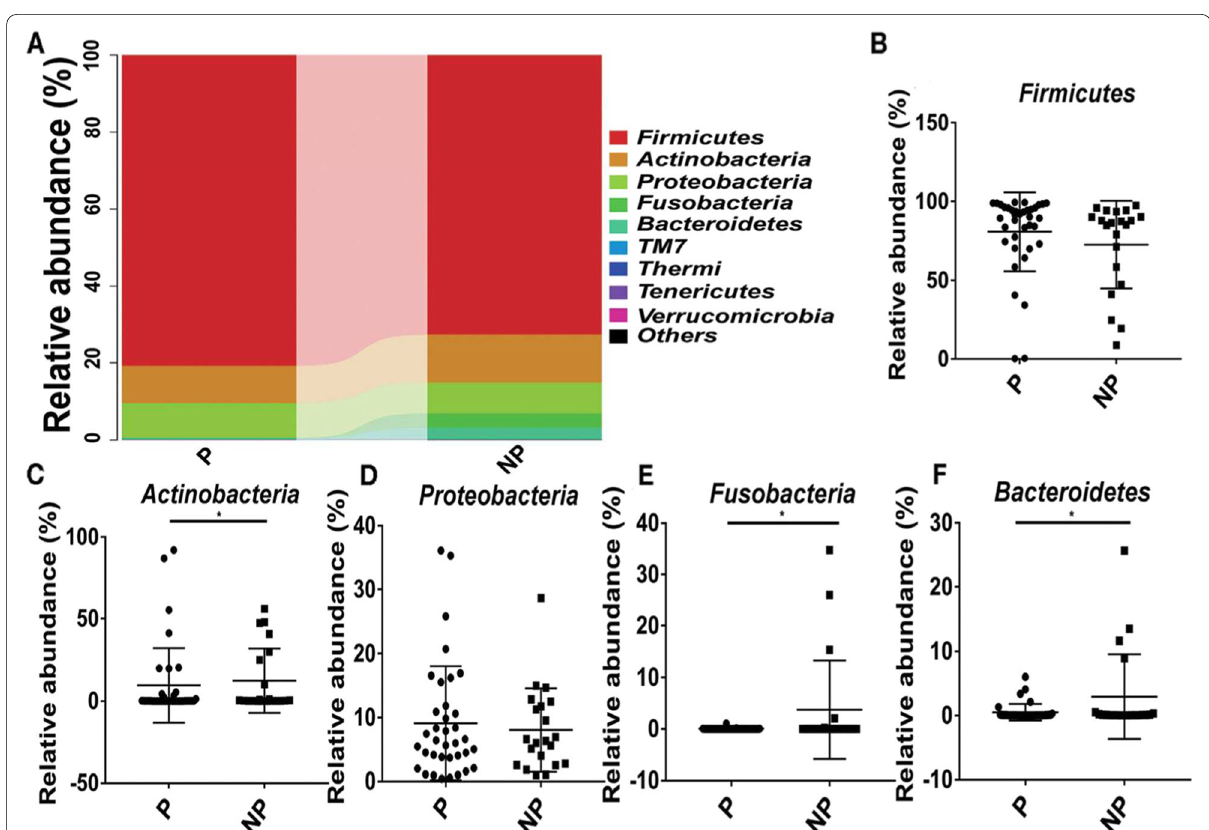
Fig. 4 At the phylum level, a comparison of the microbial communities of the P and NP groups. A Phylum-level cumulative bar charts of the main taxa in P and NP samples Firmicutes ( B ), Actinobacteria ( C ), Proteobacteria ( D ), Fusobacteria ( E ), Bacteroidetes ( F ). P, pregnancy success after embryo transfer; NP, pregnancy failure after embryo transfer; *means P < 0.05, p < 0.05 indicates significant